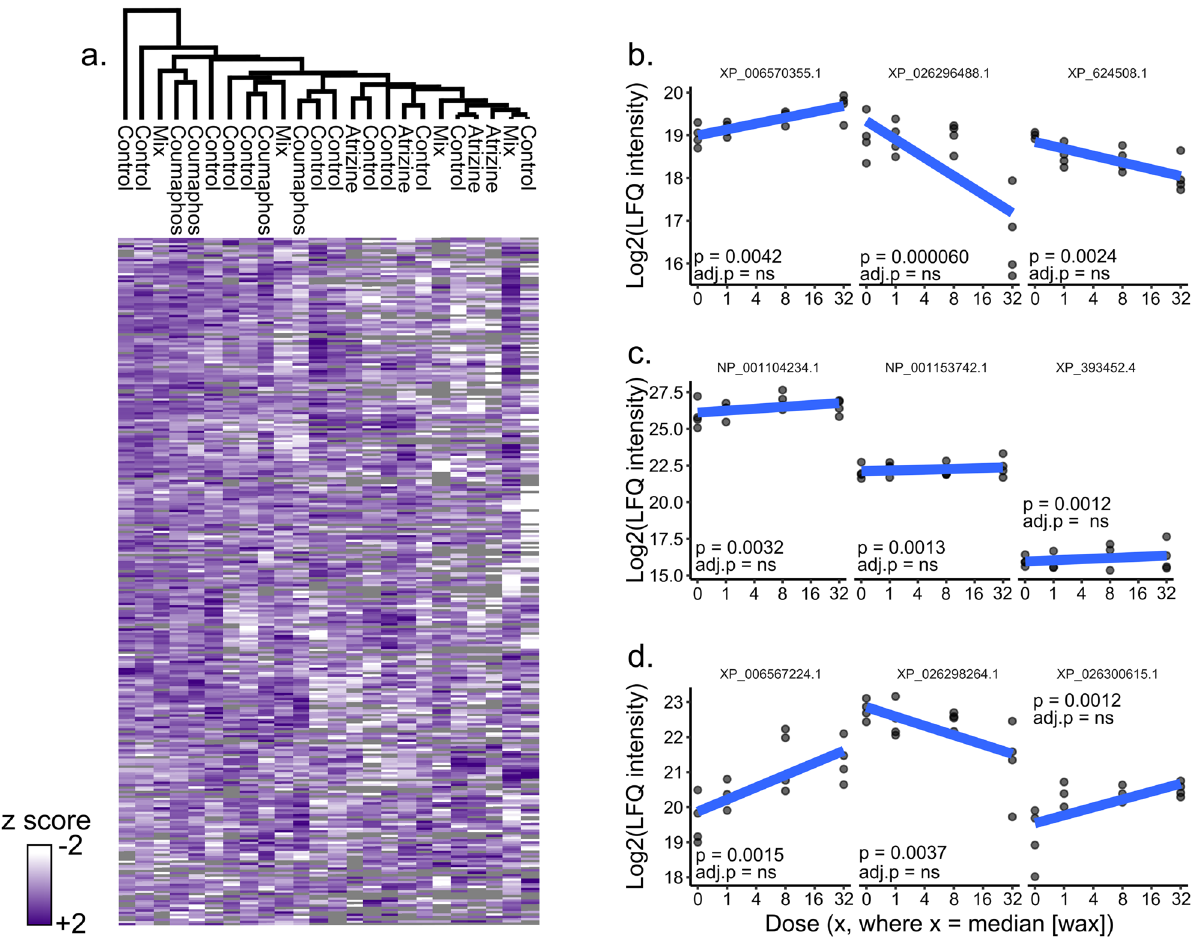
Figure 2. Evaluating the effect of pesticide exposure on queen fat body protein expression . We performed label-free quantitative (LFQ) proteomics on proteins extracted from fat bodies of atrazine-, coumaphos-, and cocktail-treated queens dosed at 0x, 1x, 8 × and 32x. a) We found no differences between the highest pesticide dose (32x) 10 and their acetone controls (10% Benjamini–Hochberg correction). Samples and proteins were clustered via Euclidian distance, 300 clusters, 10 iterations. Grey tiles indicate samples in which a protein was not identified. Top proteins linked to pesticide dose for atrazine (b), coumaphos (c), and the cocktail (d). None were significant after correcting for multiple hypothesis testing. Accessions indicate refseq IDs. ns = protein does not survive 10%